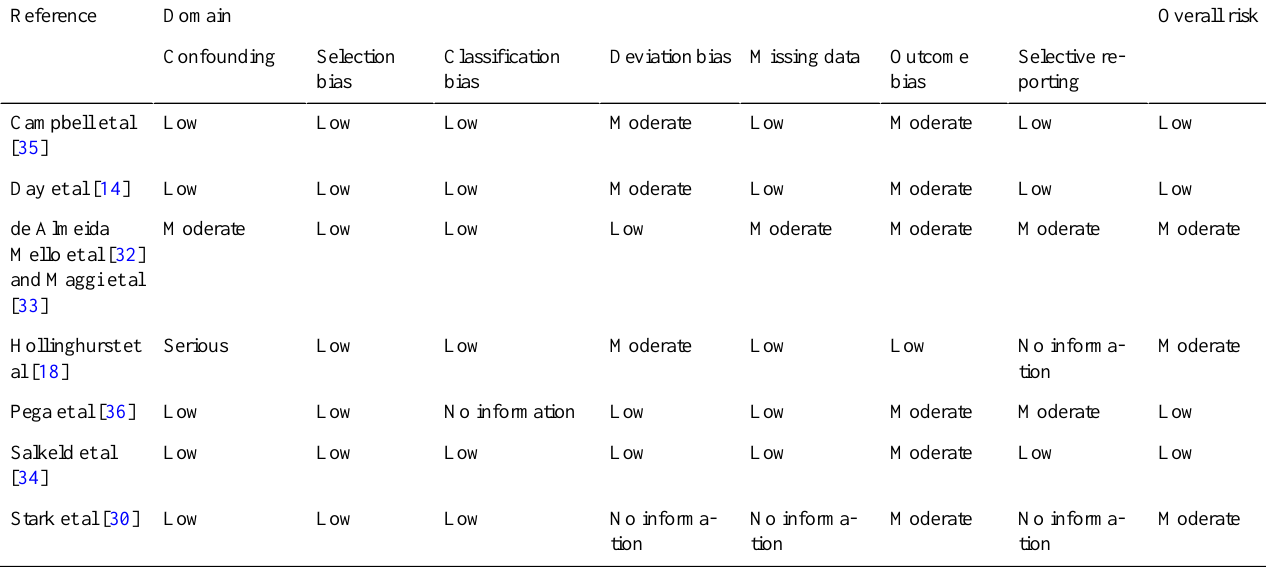
Table 1. Results of risk of bias assessment using the Risk Of Bias In Non-Randomized Studies of Interventions tool.